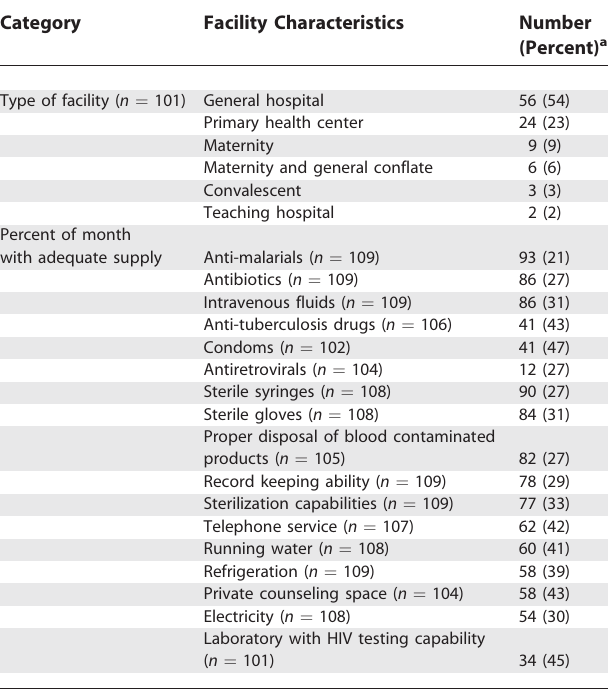
Table 1. Characteristics of 111 Participating